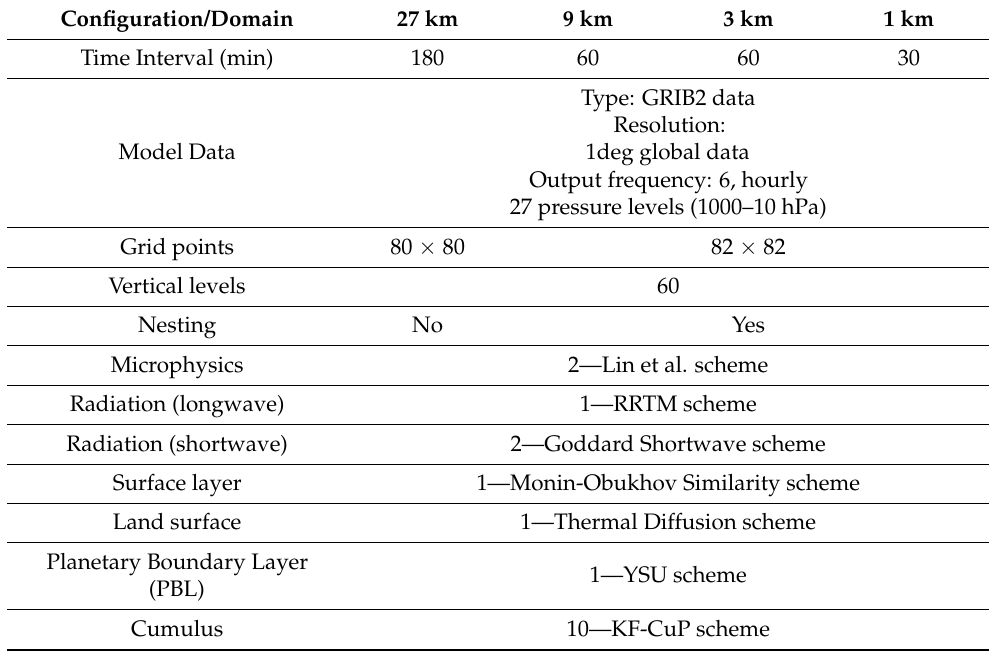
Table 2. Weather Research and Forecasting (WRF) model